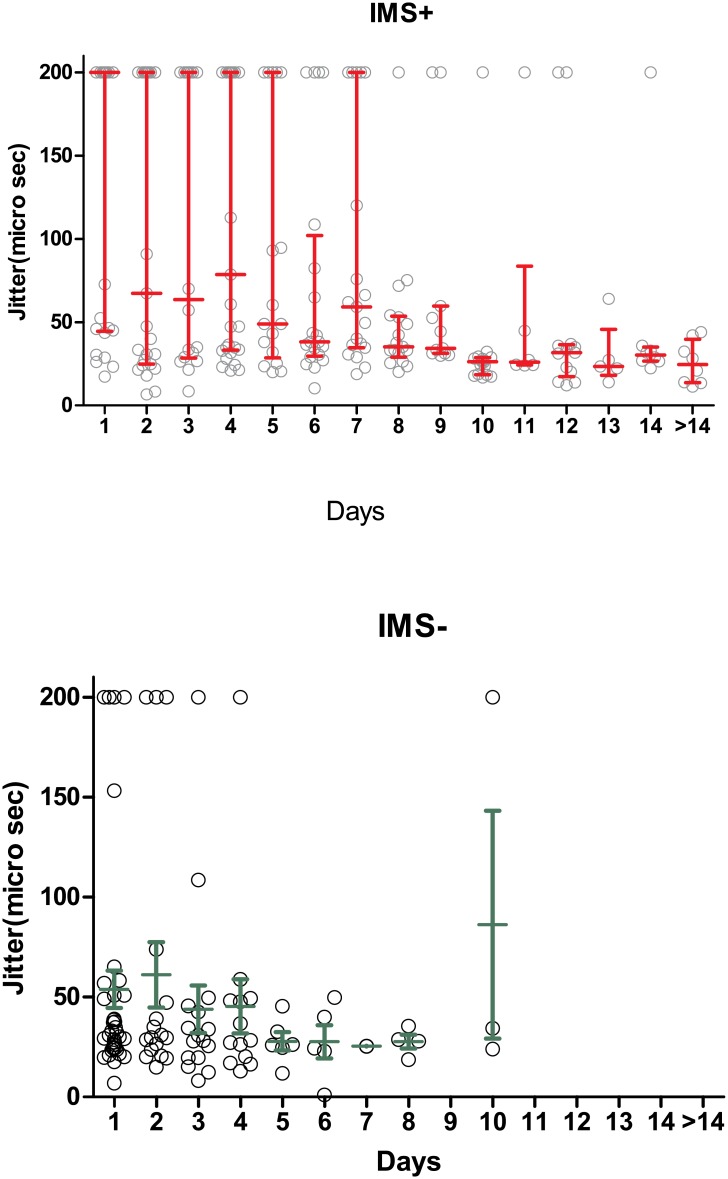
Median jitter with inter-quartile ranges in IMS+ and IMS- groups over time.